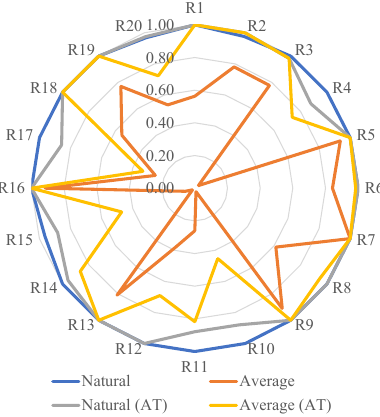
Figure 16. Identification performance for each emitter after AT under three attack scenarios with PSR = − 32 dB for Dataset 1. “Average” denotes the average identification accuracy of original DNN under three attacks. “Average (AT)” denotes the average identification accuracy of the DNN after AT under three attacks.